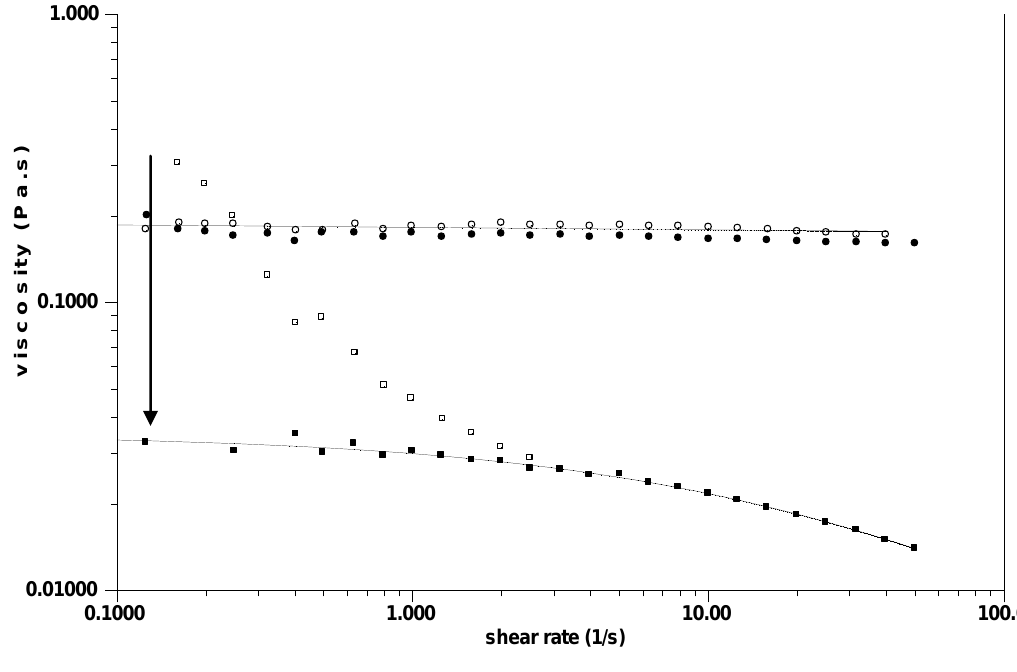
Figure 8. Steady state viscosity as a function of the shear rate before (open symbols) and after (closed symbols) protease addition. HA at 30 g/L in 0.15 M NaCl (  ,  ); SF (  ,  ). Continuous lines are the Williamson fits used to determine the zero shear rate viscosities. The arrow represents the drop in viscosity after enzymatic